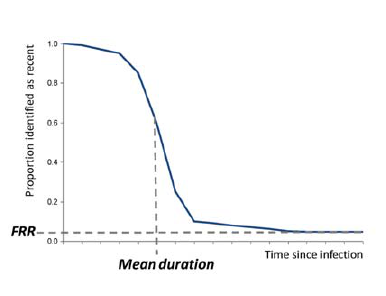
Figure 2. Proportion of individuals ‘‘test positive’’ on the incidence assay versus time since infection. The two main param- eters (mean duration and FRR) are indicated under the simplifying assumption that individ- uals do not progress (this assumption is not made in the statistical equations but is made here only to simplify the graphic